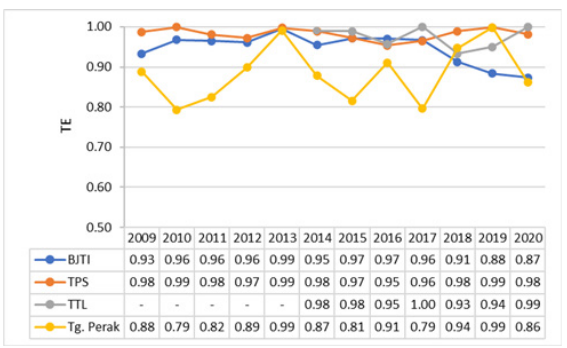
Figure 7: Technical Efficiency in Container Terminals in Tanjung Perak